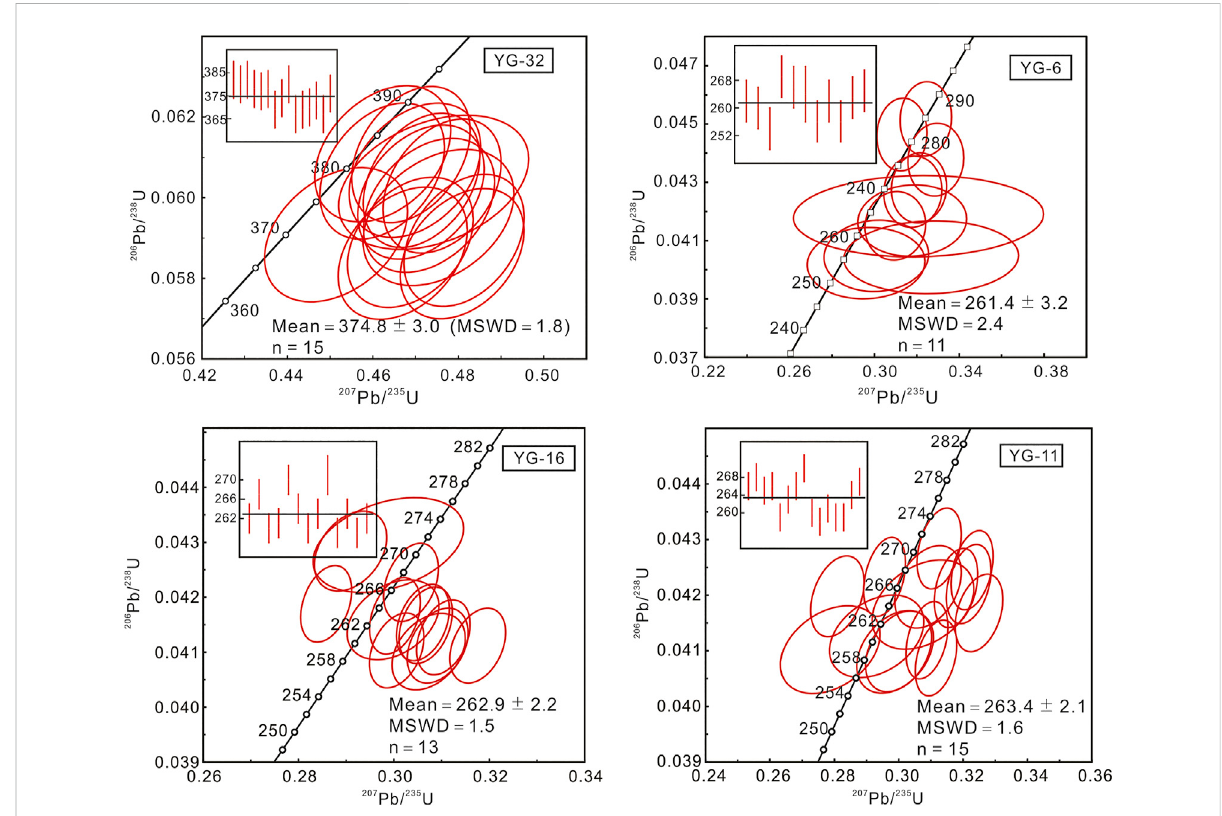
FIGURE 5 Zircon U-Pb concordia diagrams and weighted age from the syenogranite (16 YG-32), diabase (16YG-6), gabbro (16 YG-16) and biotite monzogranite (16 YG-11) in the Yagan area of northern